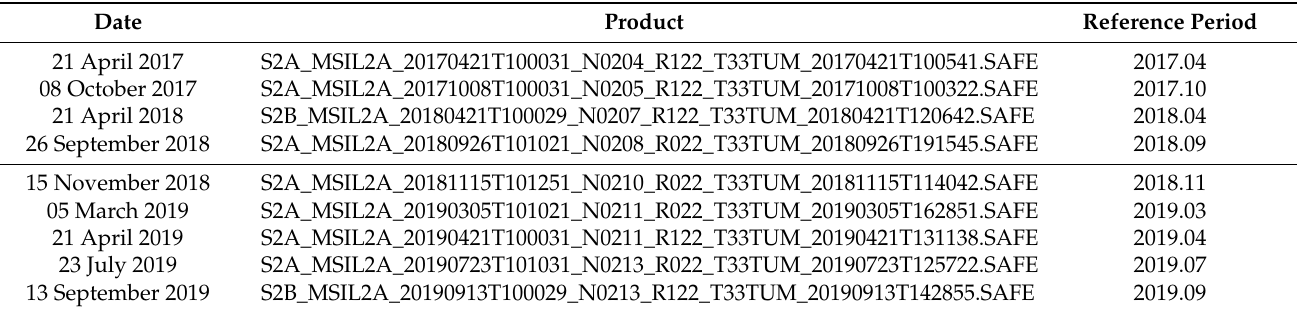
Figure 1. Map displaying the location of the study sites. Red polygons denote windthrown study sites (L1–L2) while blue polygons control sites (C1–C2). Left insets show the location of study sites with respect to the Italian peninsula (lower panel) and the position of the Friuli Venezia Giulia Region with respect to the Italian peninsula (upper panel). Map source Sentinel-2, 21 April 2017, see Table 1. Table 1. Sentinel-2 Level 2A products. Pre and post-Vaia products are separated by the thick line. A common Sentinel-1 and Sentinel-2 reference wording of the images acquisition period is also